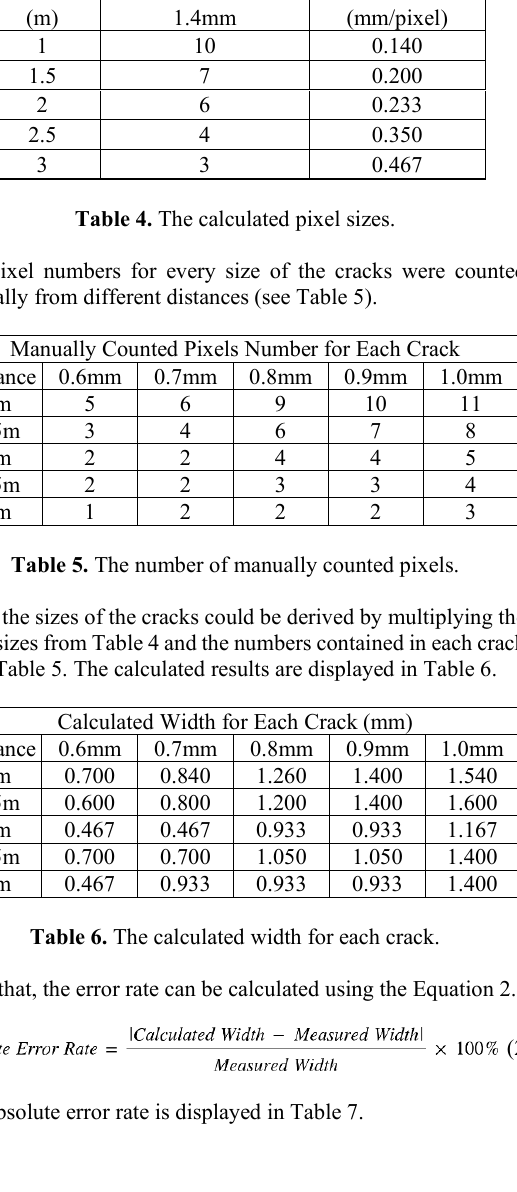
Table 8. Average pixel sizes from different